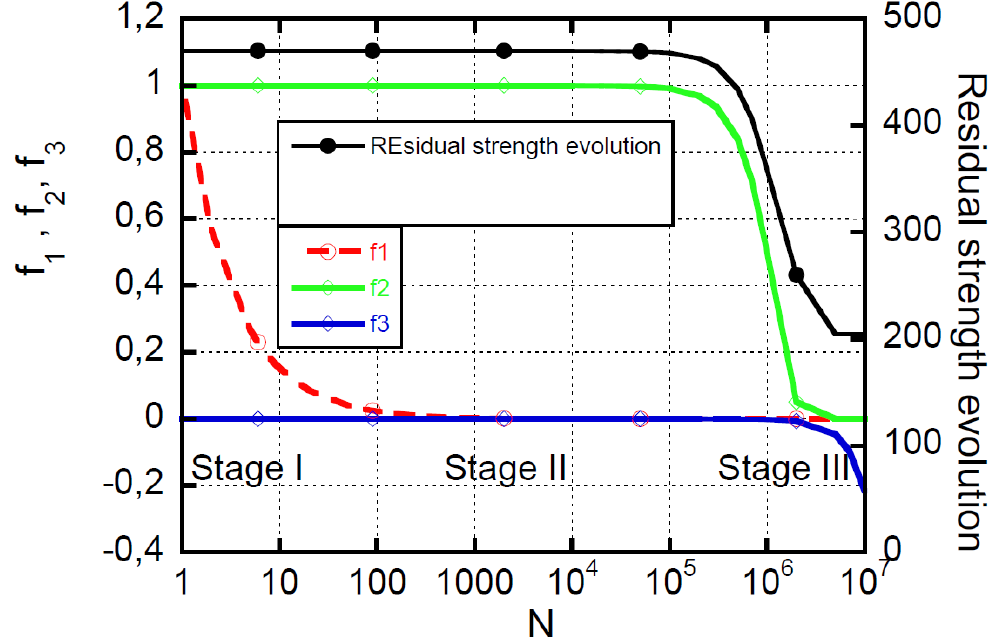
Figure 7. Model predictions of the three decaying functions ( f 1 , f 2 , and f 3 ) and the residual strength evolution for T700S/2500 carbon/epoxy laminate with (45/0/-45/90) s lay-up.